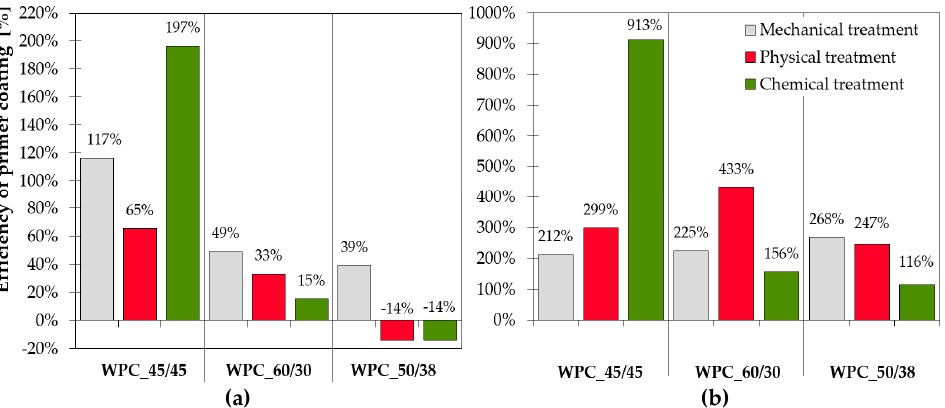
Figure 8. Comparison of surface treatment efficiency: ( a ) tensile test and ( b ) shear test. The higher the percentage is the more important the application of primer coating and the less effective the surface treatment. The negative values indicate that the results of samples without primer were better.